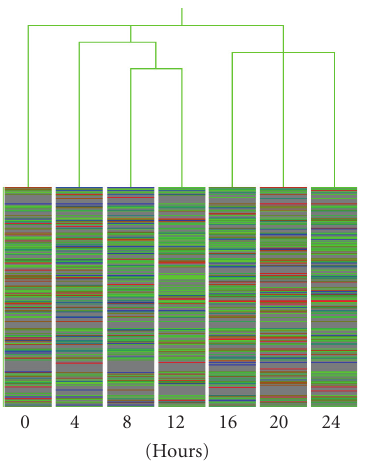
Figure 1: Gene expression profiles during C. neoformans infection; microarray analysis of mRNA levels was assessed at 0, 4, 8, 12, 16, 20, and 24 hours after C. neoformans incubation. Time points are represented by columns, and genes in rows. Red, green , and blue represent the higher, equal, and lower mRNA level relative to that of zero time point. A hierarchical clustering analysis of genes with expression levels that changed during C. neoformans and HBMEC interactions was performed. The distance among infectomic pro- files of HBMEC is shown. Each lane represents a result form a gene chip. Genes with high intensity reading are shown in bright colors; genes with low intensity reading are in dim colors (grey) so they can be distinguished during analysis.